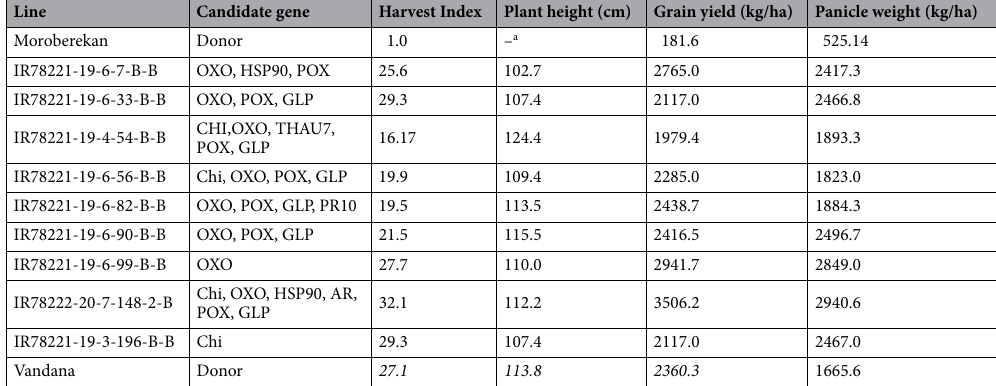
Table 3. Means of agronomic traits evaluated under drought condition of selected F 6 Vandana/Morobekan intermated lines with resistance to field blast and the candidate genes detected in the genomes. The lines were exposed to less than 10 cm rainfall for at least 30 days during the reproductive stage at IRRI, 2004 wet season. a No data.